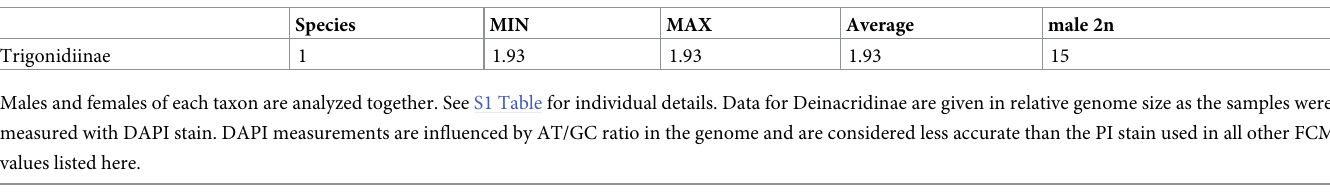
monophyletic. The genus Chorthippus is found polyphyletic: Chorthippus pullus is placed in a group containing Myrmeleotettix , Omocestus , and Stenobothrus . The remainder of Chorthippus is paraphyletic with respect to Gomphocerippus , Gomphocerus , and Stauroderus . Plotting genome sizes on the tree shows consistent values of mean genome size in different clades of the Orthoptera tree (Fig 4). The sizes of all Gryllidea genomes are between 1C = 0.91 pg ( Oecanthus sinensis ) and 2.88 pg ( Acheta domesticus ), with the exceptions of Neoscapteriscus borel- lii (3.41), Ornebius kanetataki (3.28) and Gryllotalpa orientalis (4.21). The values in Tetrigidae range between 2.22 and 2.36. On the other hand, all members of Tettigoniidea and Acrididae show values between 4.01 and 14.15. The exceptions are Hadenoecus subterraneus (1.55) at the lower end and Stauroderus scalaris (15.04 / 16.34), Psophus stridulus (16.44), Podisma pedestris (16.93), Eusthystira brachyptera (17.94), Stethophyma grossum (18.11), Deracantha onos (18.26), Bryodemella holdereri (18.41), Chrysochraon dispar (19.09), and B . tuberculata (21.92).